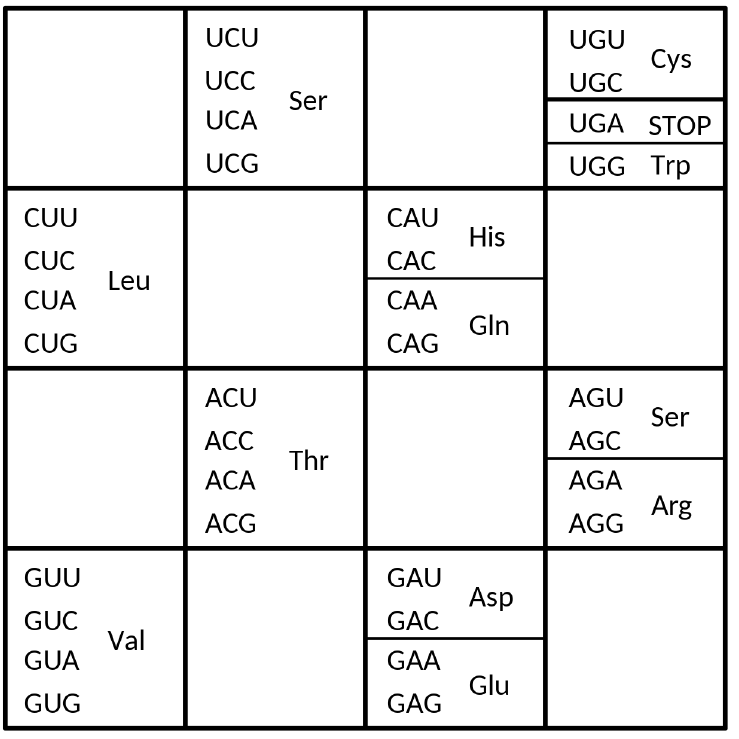
Fig 1. The chess board pattern in the genetic code table. When all SSN and WWN codon boxes are left out, a chess board pattern emerges (see text). In this representation it can immediately be seen that mixed SW/WS codon boxes with a middle-Y (U or C) are fourfold degenerate codon boxes, while mixed SW/WS codon boxes with a middle-R (A or G) are split codon boxes.